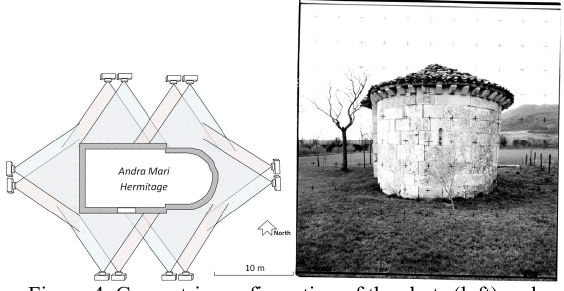
Figure 4. Geometric configuration of the shots (left) and example of photograph (right) from the geometric documentation of the hermitage of Andra Mari.